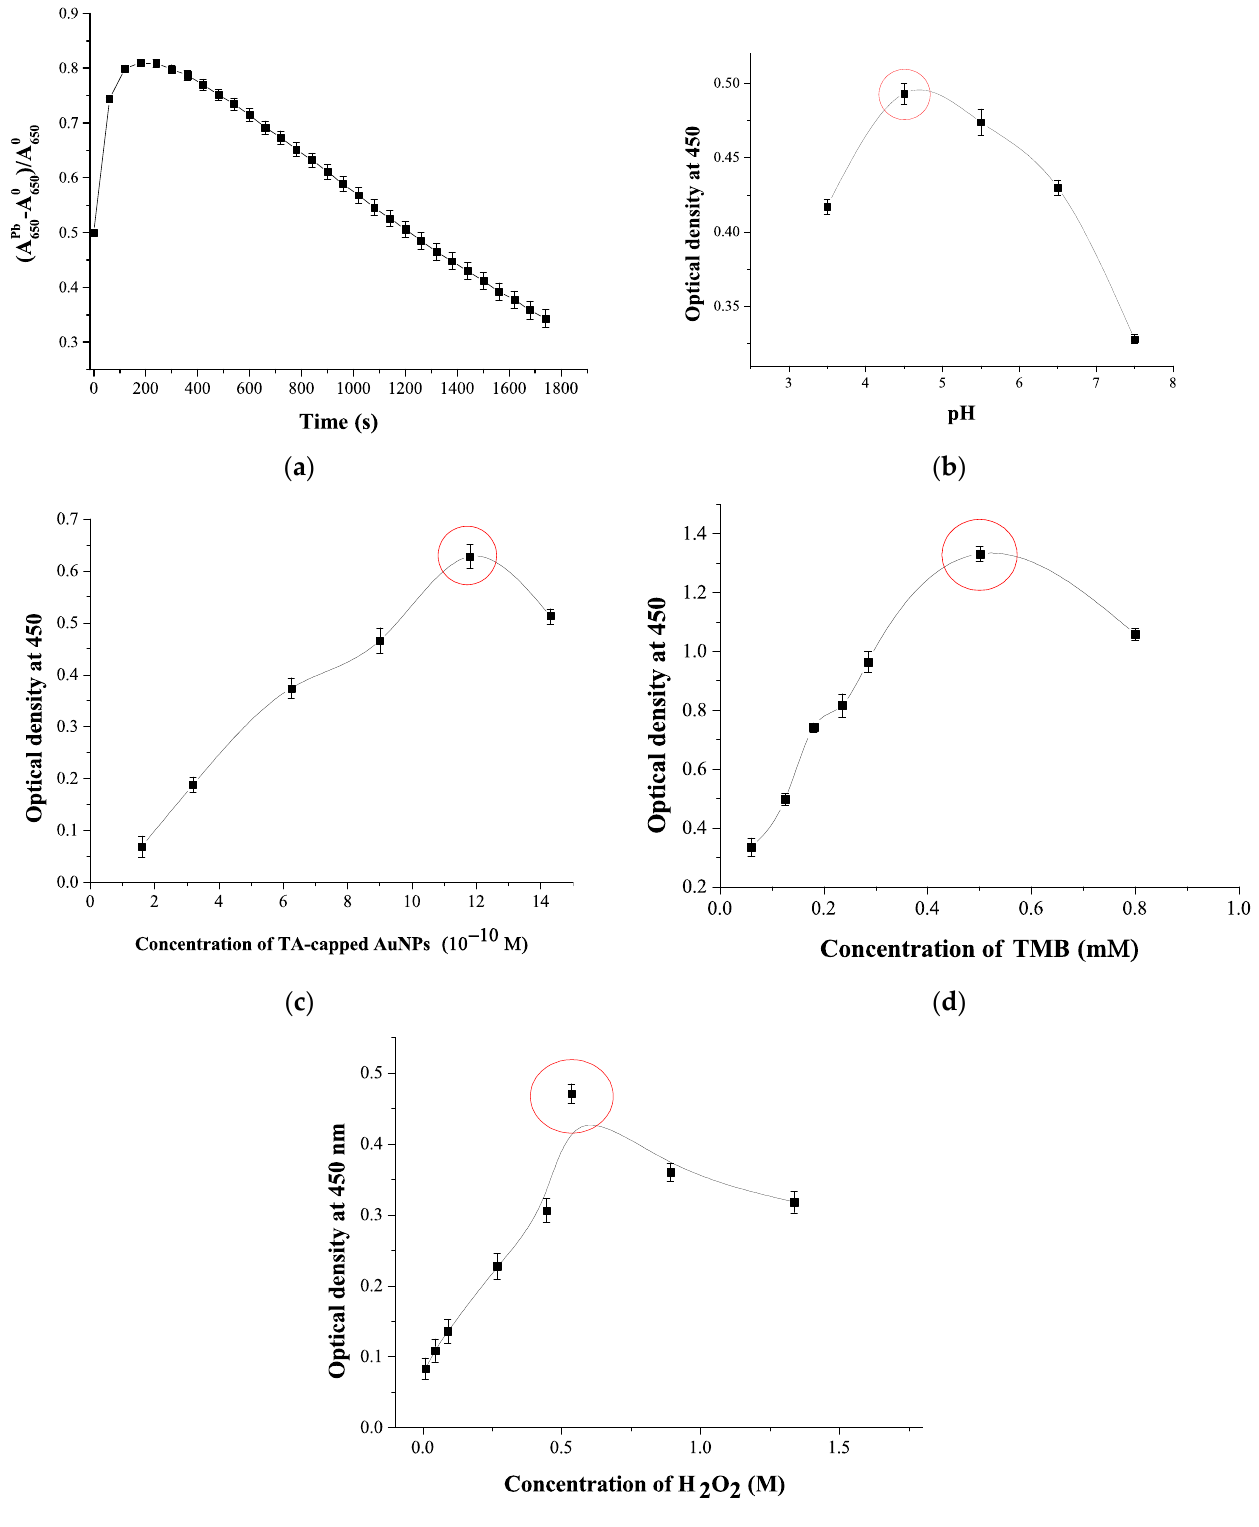
Figure 3. Optimization of the analysis conditions: ( a ) Time dependence of the colorimetric response in the presence of Pb 2+ relative to the background signal; ( b ) pH effect to analytical signal; ( c ) Concentration of TA-capped AuNPs; ( d ) Concentration of TMB; ( e ) Concentration of H 2 O 2 . Experimental conditions: 11.8 × 10 − 10 M TA-capped AuNPs, 0.5